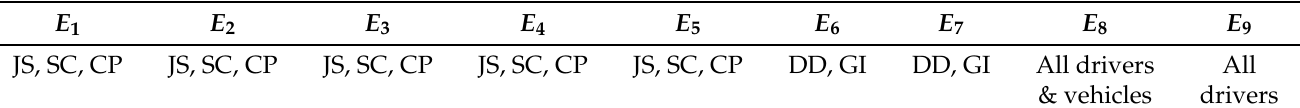
Table 4. CRT for our courier